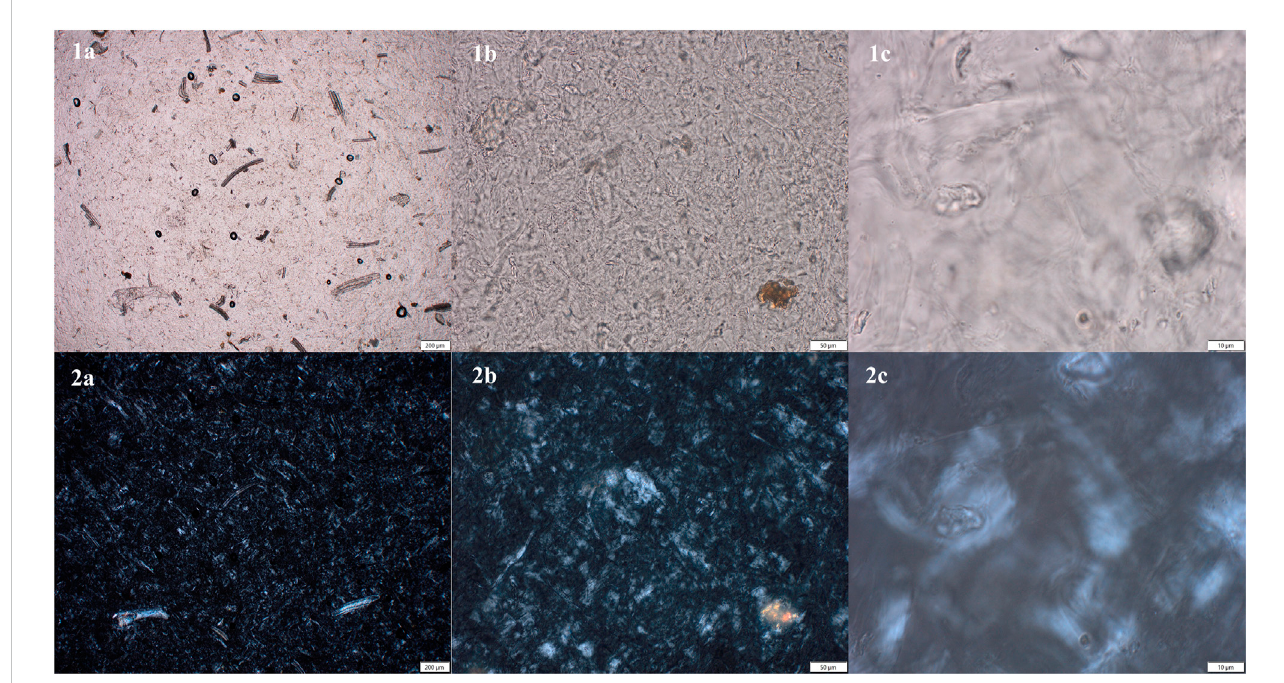
FIGURE 1 Lightmicroscopemicrographsofcitrus fi ber10 wt%mixedwithwaterusingbright fi eld,1a – c,andpolarizedlight2a – c.Thescalebarsarefora200 μ m,b 50 µm c 10 µm.